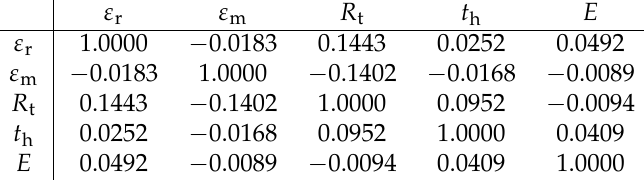
Table 4. Correlations between the factors in the main programme